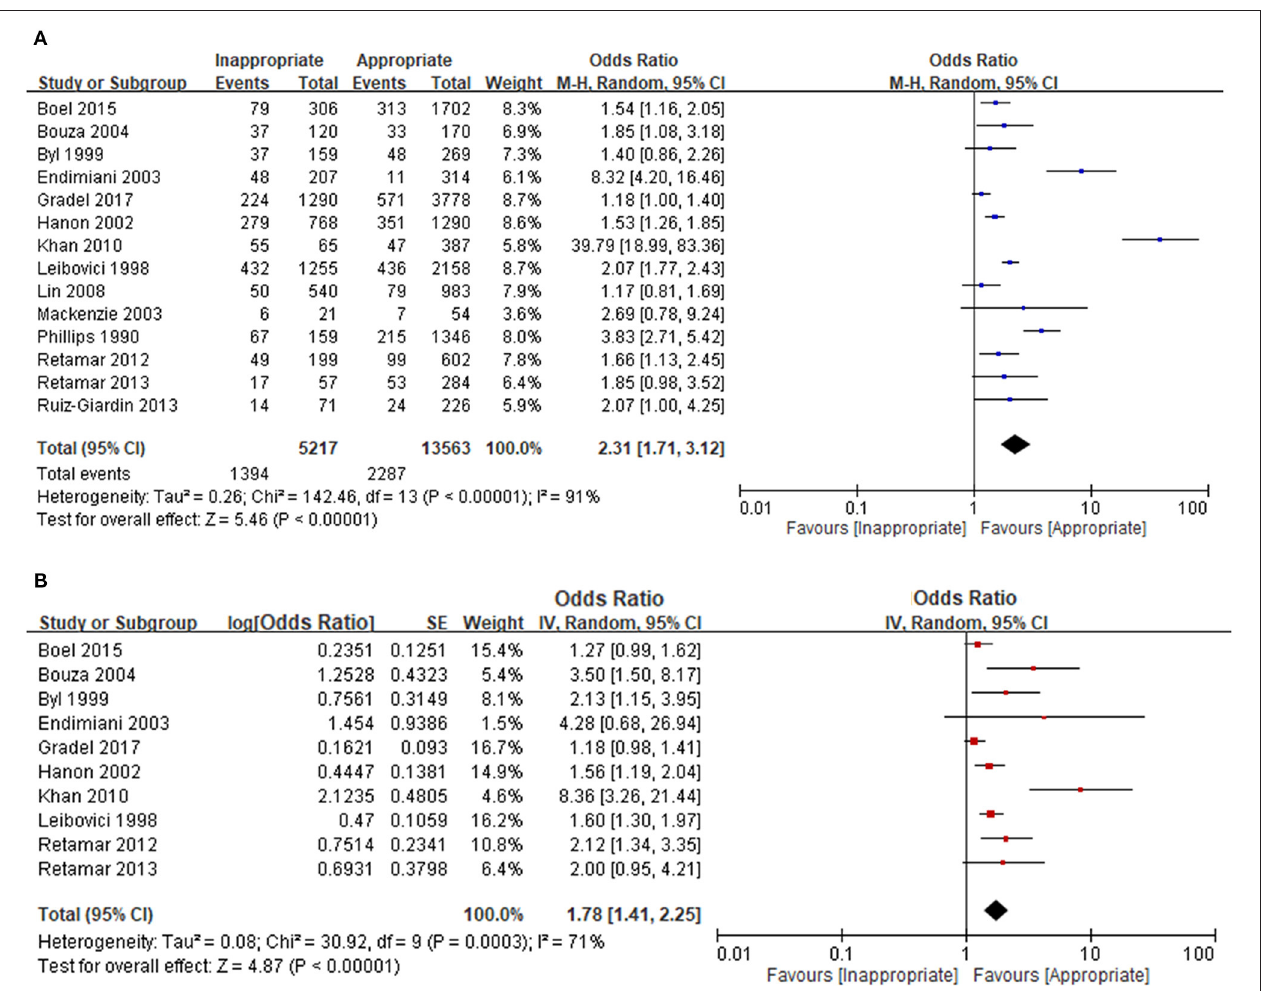
FIGURE 2 | Unadjusted (A) and adjusted (B) analyses in studies dealing with overall bacteraemia. *Only included non-specific comorbid patients with bacteraemia without the unique focus, causative microorganisms, and acquisition